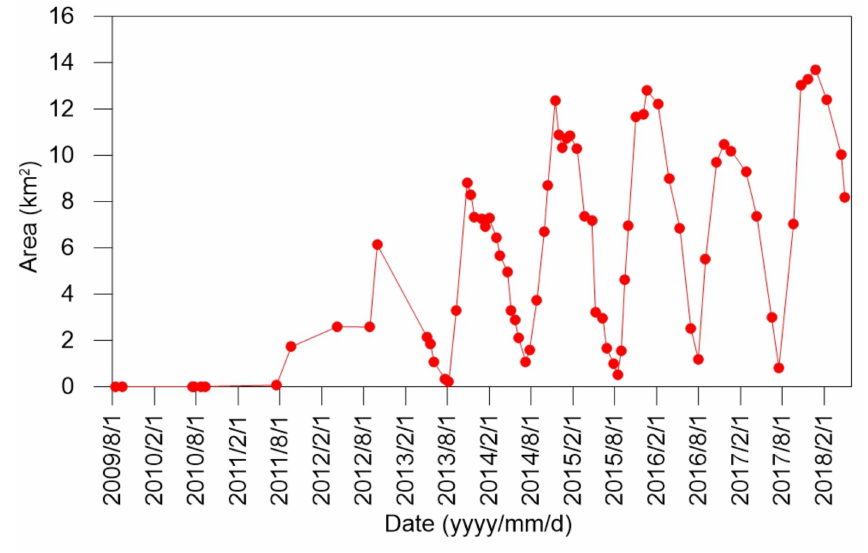
Figure 3. The change in the surface area of the water body of Qingtu Lake over